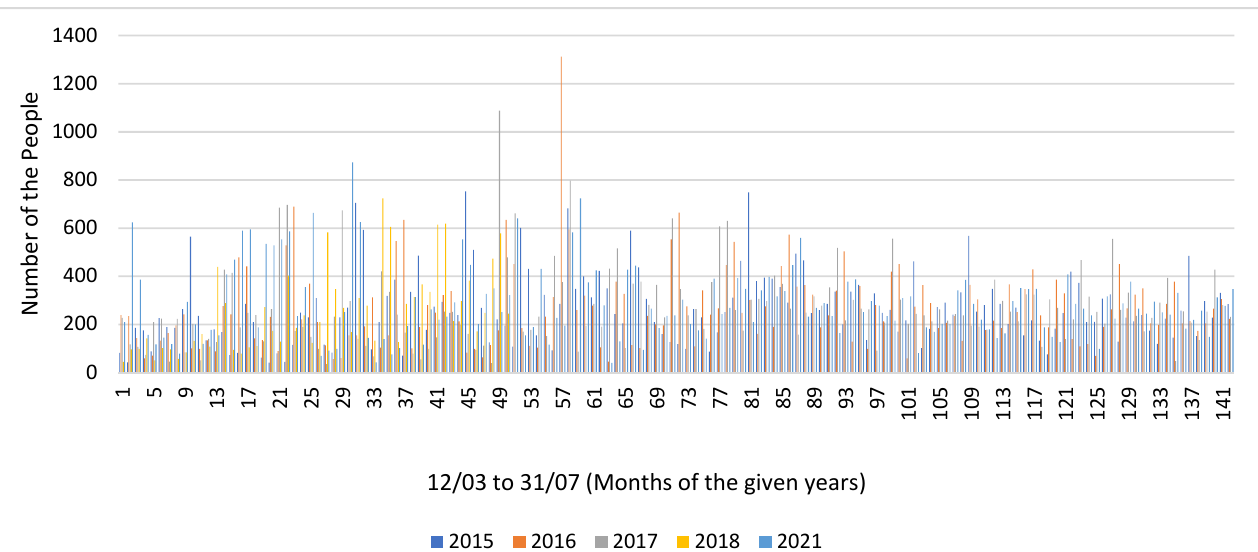
Figure 6. The frequency of visitors of Training Forest Enterprise Masaryk Forest K ř tiny (Forest Road “ Č ervená”) in the subsequent years before and after COVID-19 (March to July).